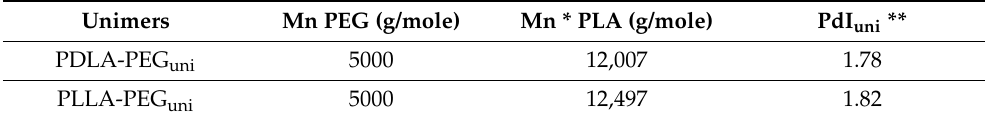
Table 1. Number-based molecular weight and polydispersity index of synthesized PLA-PEG unimer. Unimers